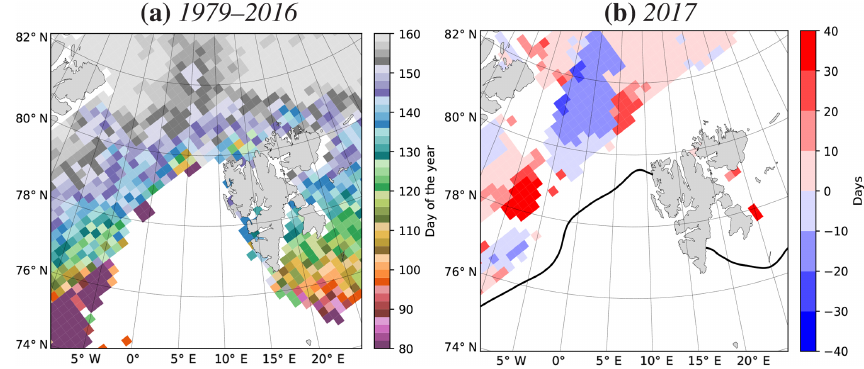
Figure 13. (a) Climatology (1979–2016) and (b) anomaly relative to the climatology (2017 minus 1979–2016) of snowmelt onset date based on NASA GSFC data. In panel (b) , white shading south of the 2017 sea ice edge (line) indicates open